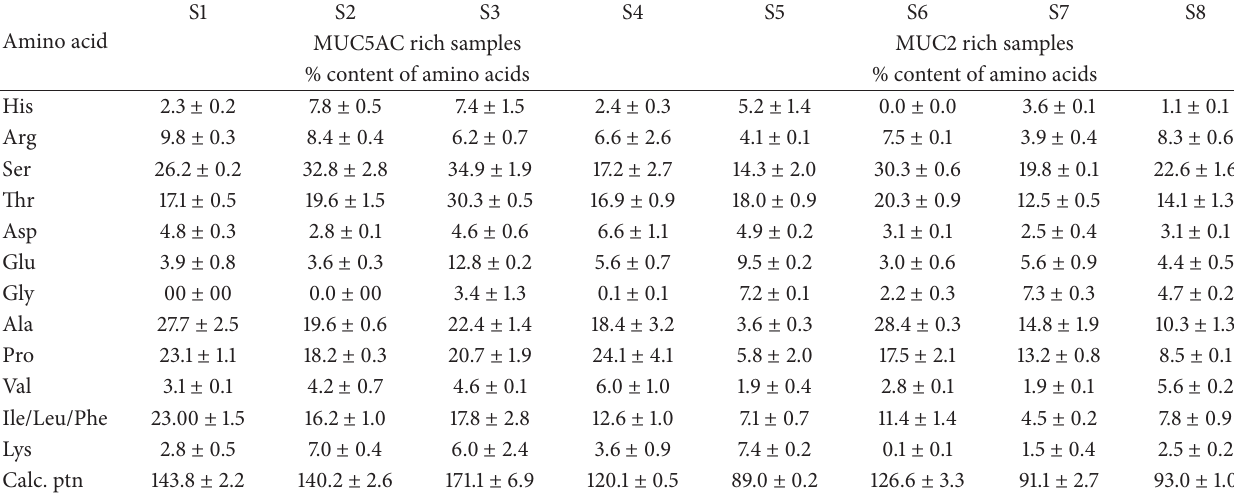
Table 3: Amino acid composition of papain digested chronic sinusitis